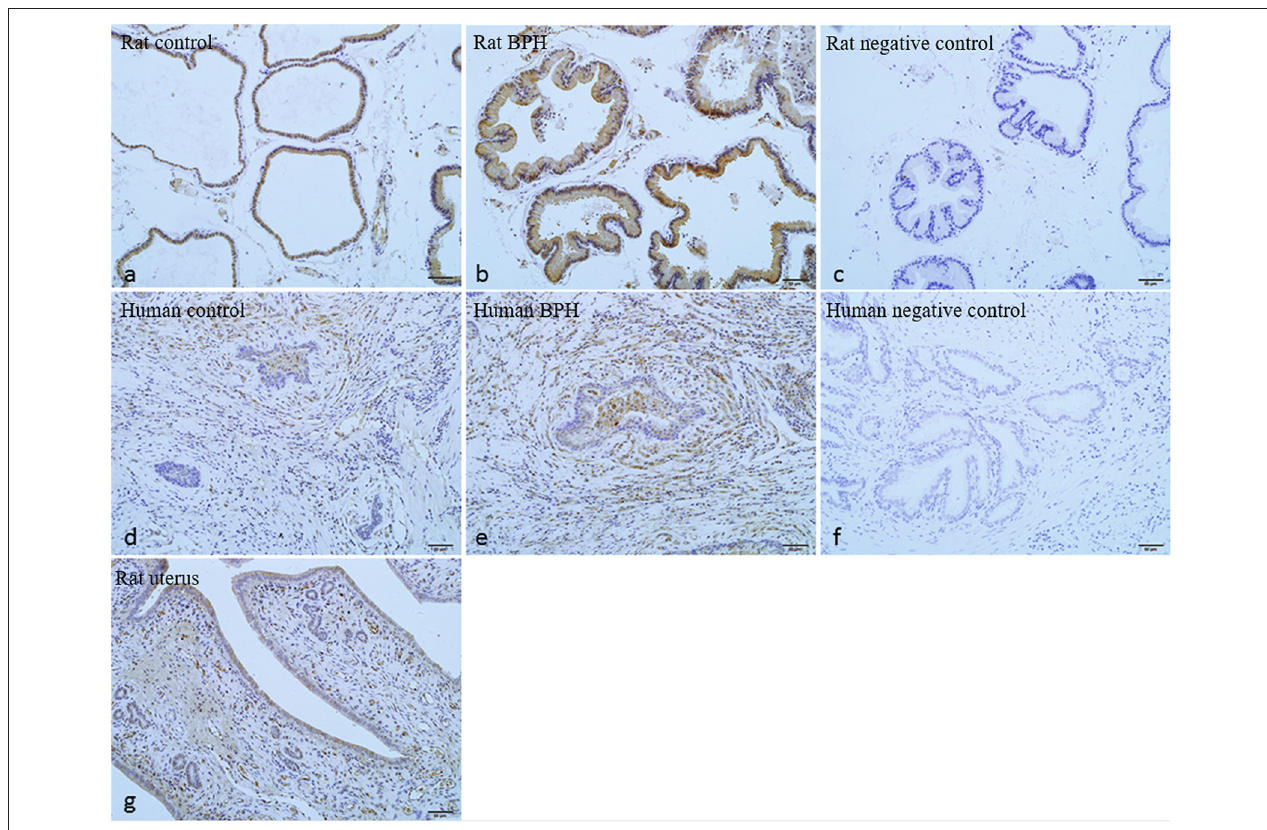
FIGURE 7 | Immunohistochemistry of OTR. (a) Normal rat prostate. (b) BPH rat prostate. (c) Negative control of rat prostate. OTR mainly distributed in epithelium and partly distributed in stroma. (d) Normal human prostate. (e) BPH human prostate. (f) Negative control of human prostate. OTR mainly distributed in stroma. (g) Rat uterus tissue was used as positive control for OTR (magnification ×